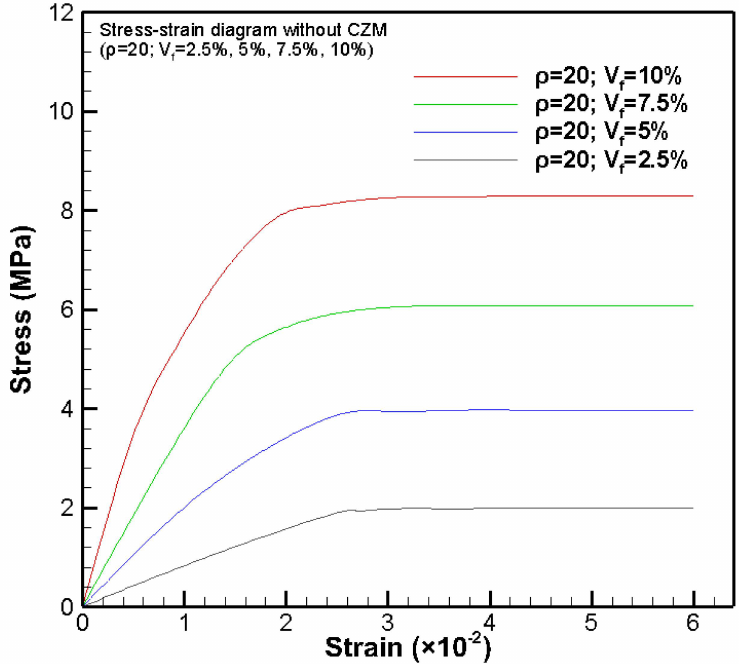
Figure 18. Effective stress-strain diagrams of the PNC (stack nanoparticle configuration) without CZM at the nanoparticle volume fraction of V f = 2.5%, 5%, 7.5%, and 10%, respectively ( ρ = 20).